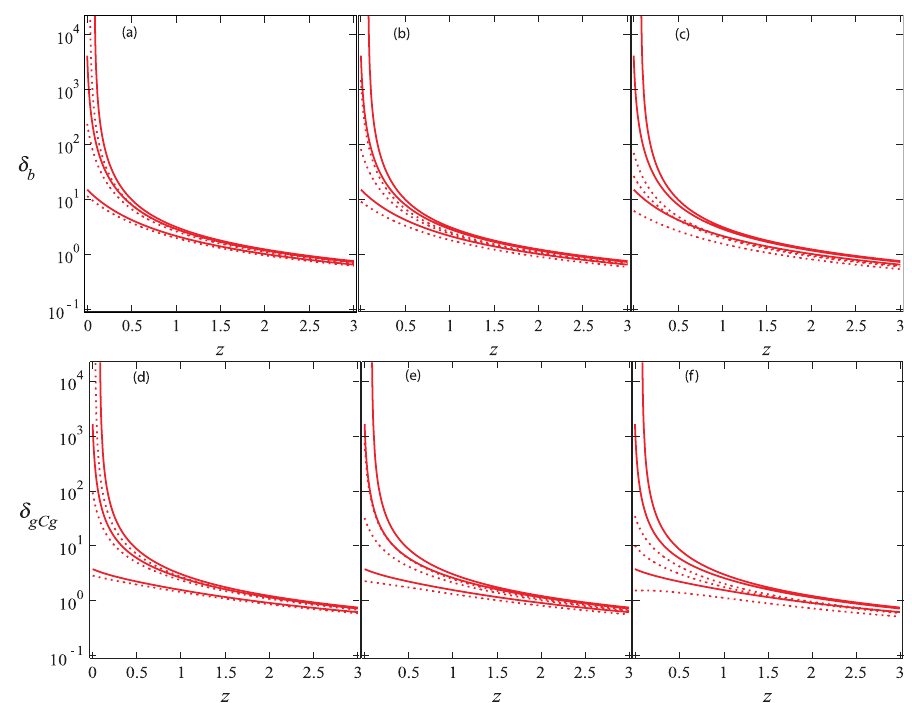
Fig. 1. Growth of perturbations for the SCM in gCg-dominated universes. Top (panels a–c): δ b vs z . Bottom (panels d–f): δ gCg vs z . Panels (a–c): from top to bottom, the values of α are 1, 0.5, 0. The solid line represents δ b without the effect of the additive term σ 2 − ω 2 , whereas the dotted line is shown with its presence. The value of β is 0.01 in panel (a), 0.02 in panel (b), and 0.04 in panel (c). Panels (d–f): similar to panels (a–c) but for δ gCg